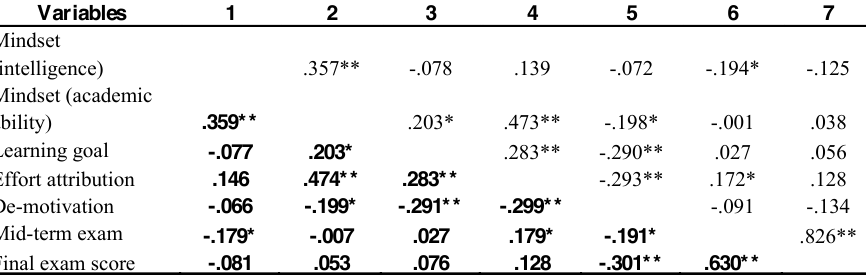
Zero-order (figures in the upper half of the matrix) and partial correlations controlling for prior GPA (figures in bold in the lower half of the matrix) between the main